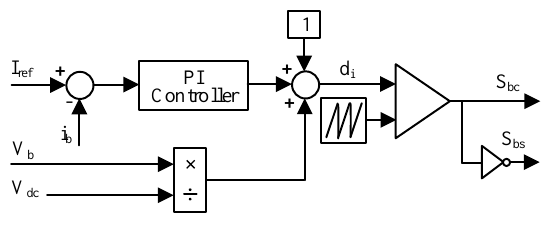
Figure 11. Control scheme for the DC/DC converter in boost